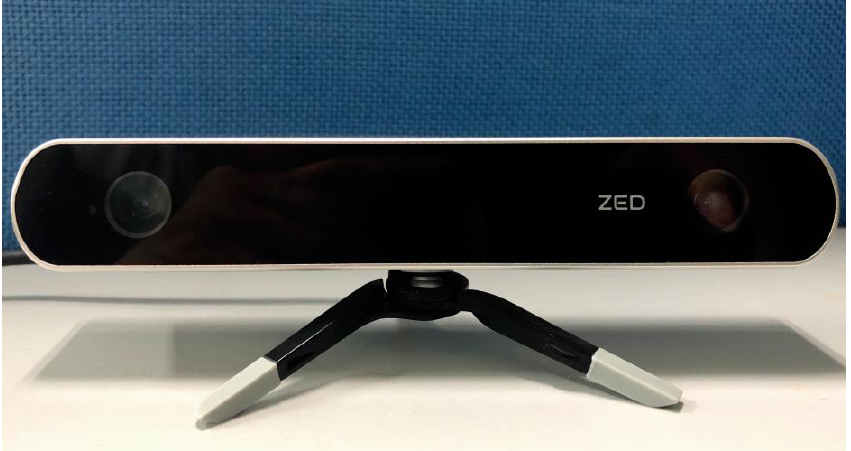
Figure 11. ZED stereo camera used in this experiment.